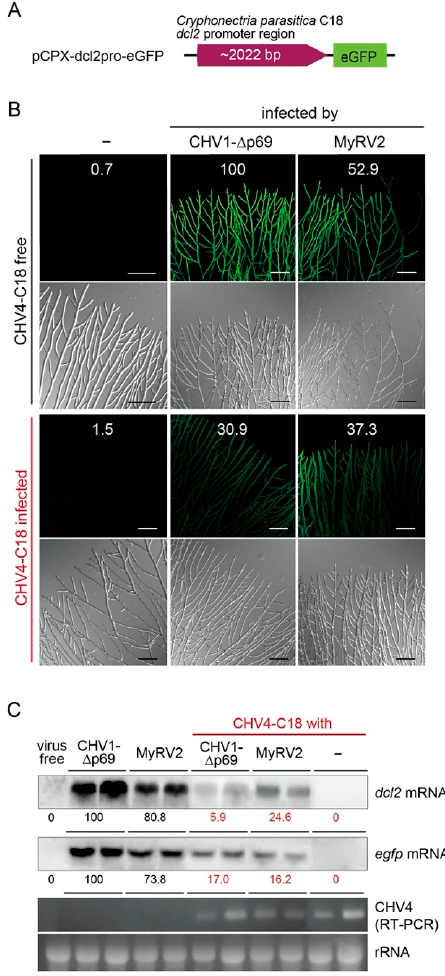
Figure 1. CHV4 suppresses antiviral RNA silencing via inhibiting dcl2 transcriptional upregulation. ( A ) The organization of a reporter constructs pCPXHY-C18- dcl2pro :: egfp . An egfp gene fused with a 2.2 kbp C. parasitica C18 genomic sequence containing the dcl2 promoter region was cloned